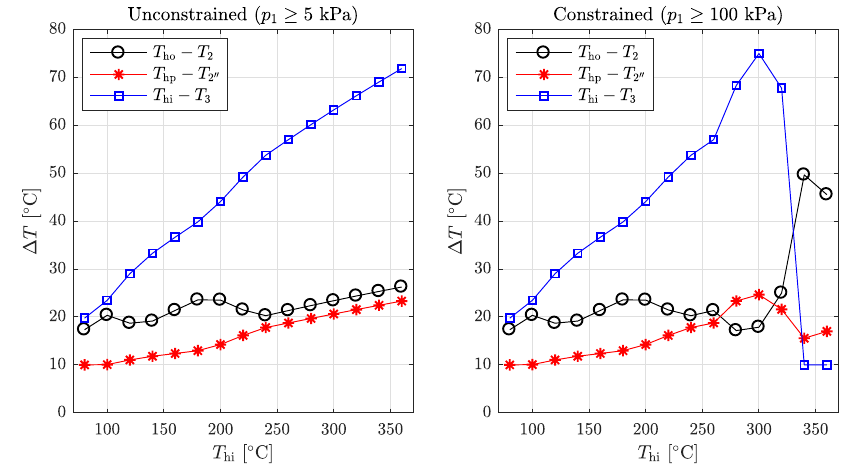
Figure 7. Temperature differences within the evaporator for the optimal cycles obtained for the unconstrained ( left ) and constrained ( right ) condensation pressure cases with ω =